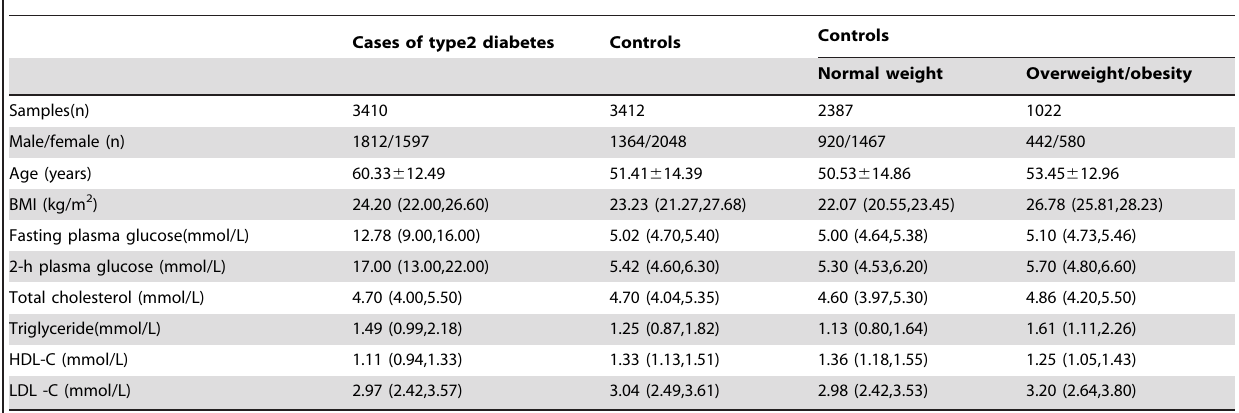
Table 1. Clinical characteristics of the study sample population.